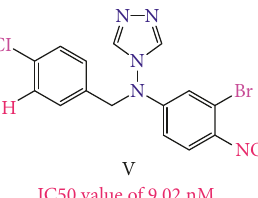
Figure 10: Aromatase inhibition activity of N-(3-Bromo-4-nitrophenyl)-N-(4-chlorobenzyl)-4H-1,2,4-triazol-4-amine (V).